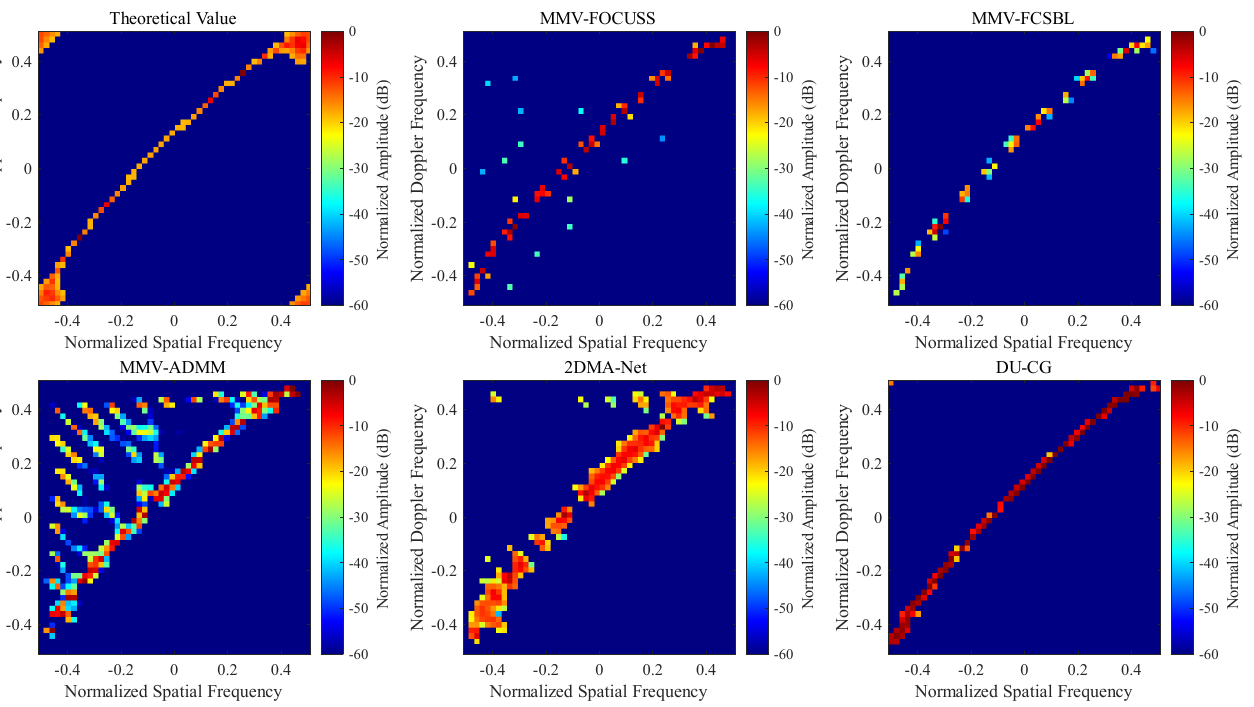
Figure 10. Clutter spectrum estimation results obtained using different methods in the non-ideal case with a non-side-looking angle of 16.5°.